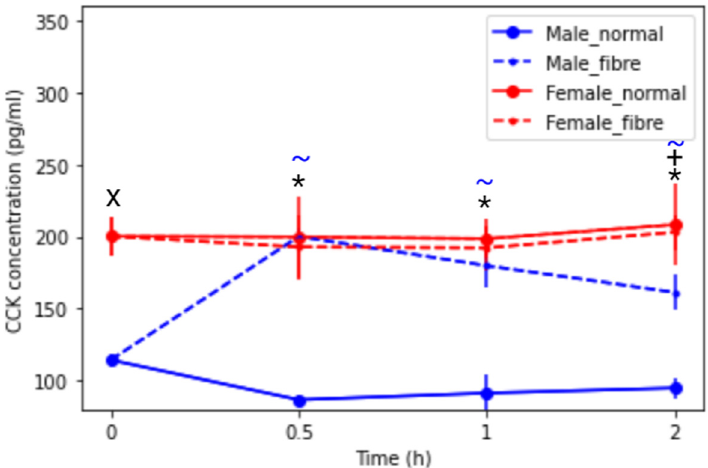
Figure 4. Cholecystokinin concentration (pg/mL) over time of male and female rats under fasted and fed states (normal housing food and fibre meal), (mean ± SD, n = 6). The following symbols denote a statistical significance ( p < 0.05) showing a sex difference between male and female rats: fasted state (X), normal meal (*) and fibre meal (+); and a food effect between the feeding intervention: normal and fibre (~).